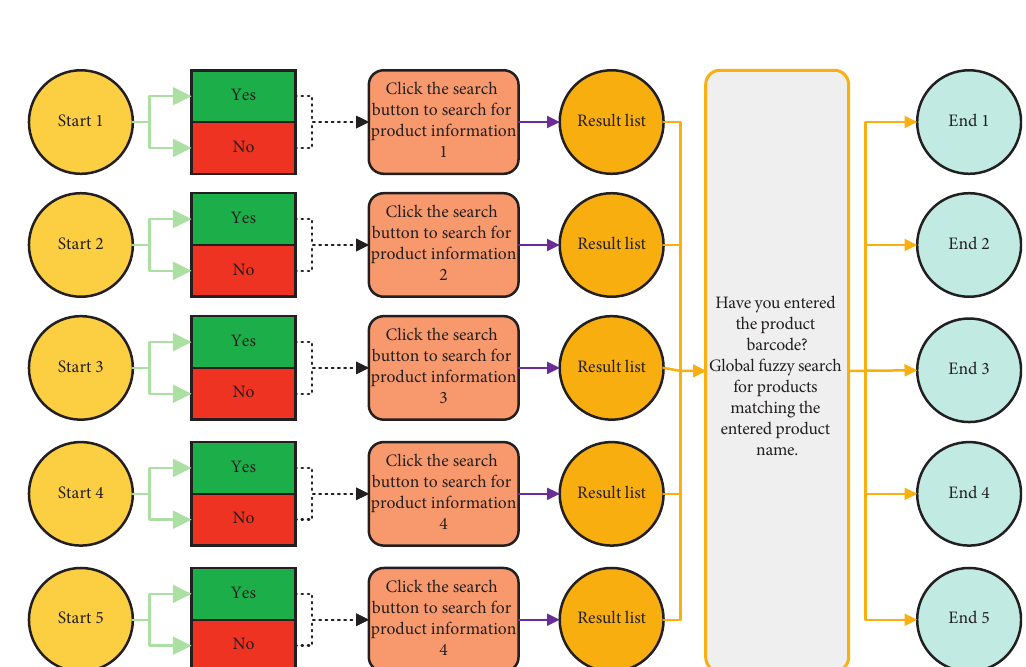
Figure 3: Flowchart of commodity data query.